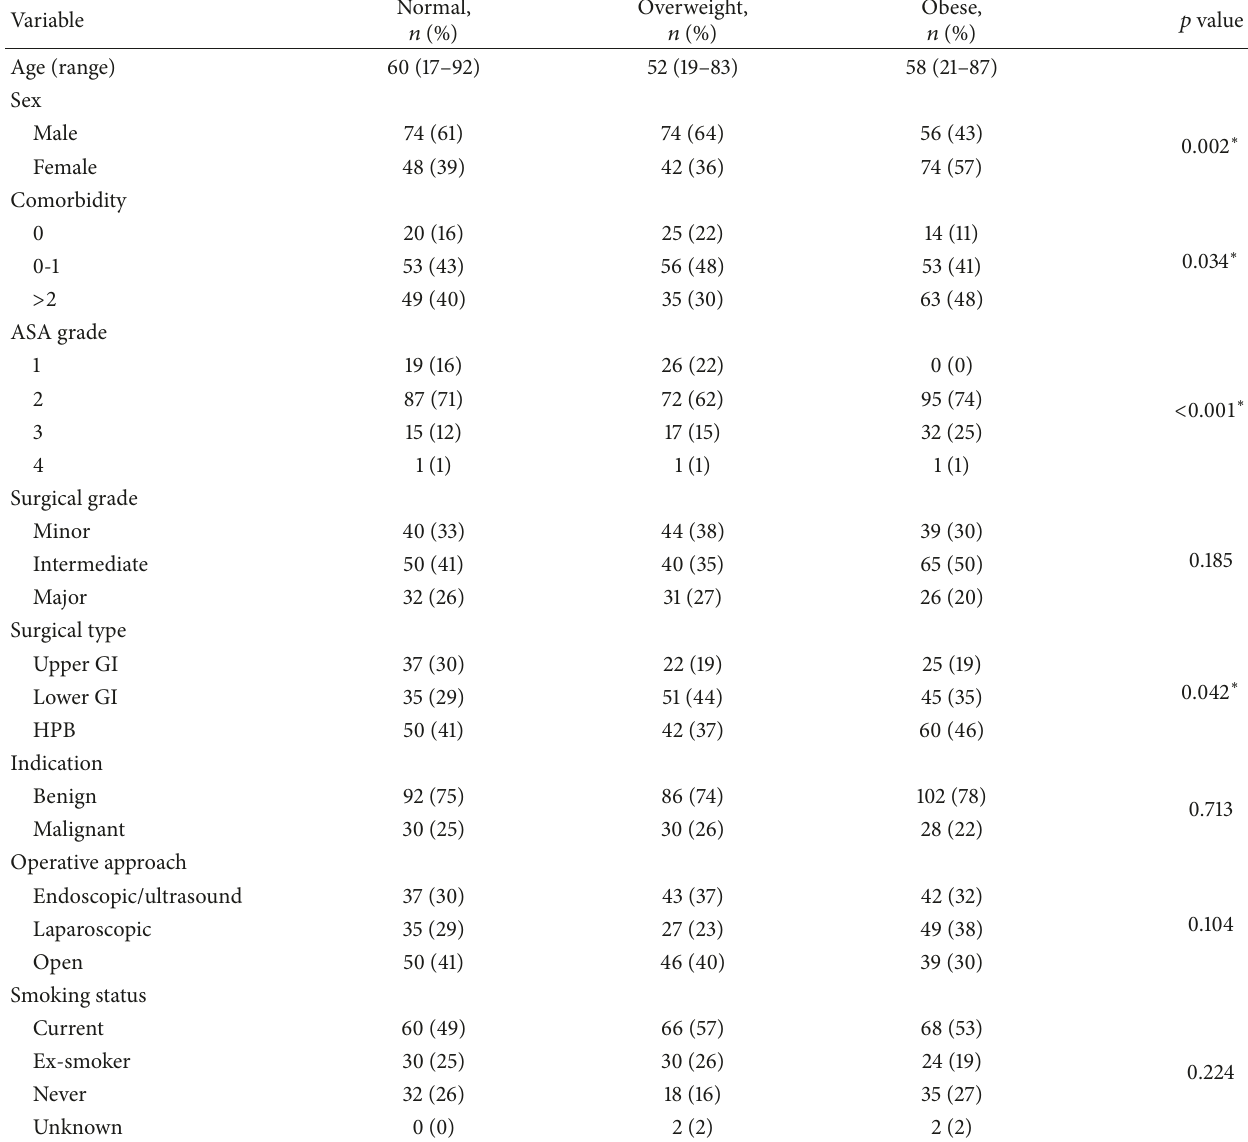
Table 1: Baseline characteristics of patients by body mass index